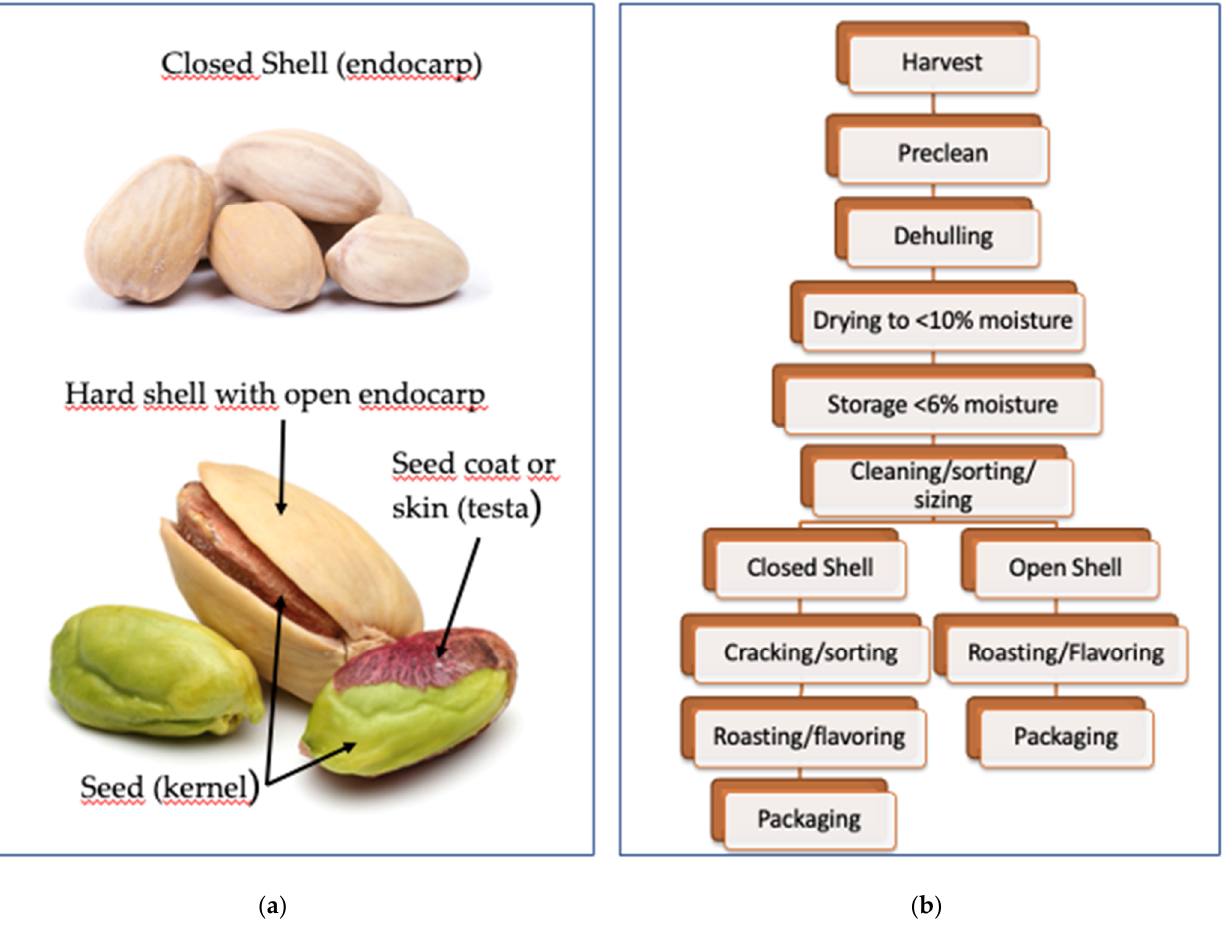
Figure 2. ( a ) Pistachio nuts (closed and open shell) illustrating their unique colors due to the presence of bioactive compounds, mainly lutein (yellow), anthocyanins (red) and chlorophyll (green); ( b ) pistachio processing: from harvest to consumer.